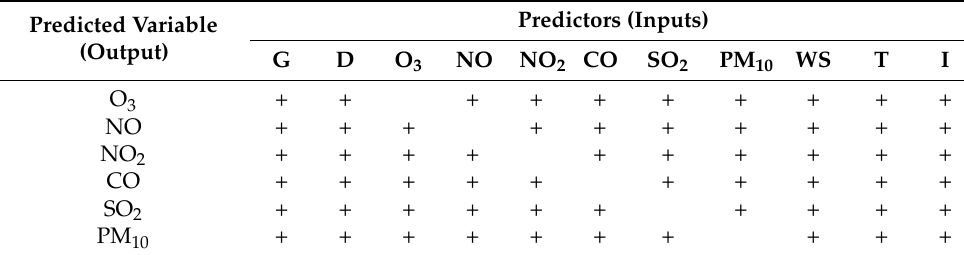
Table 1. Classification of predictors for each of the 6